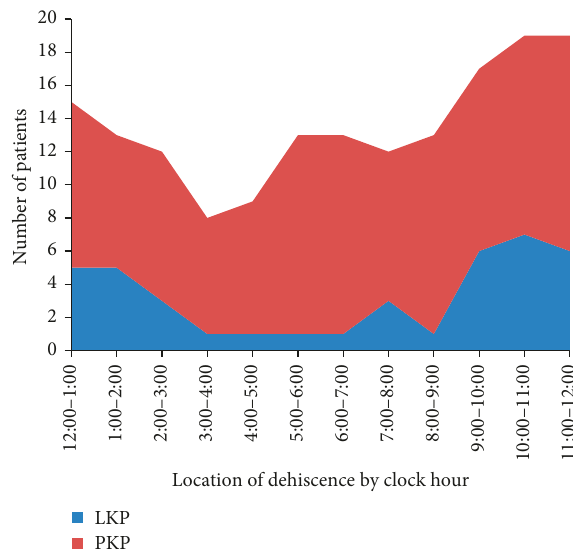
Figure 4: The location of wound